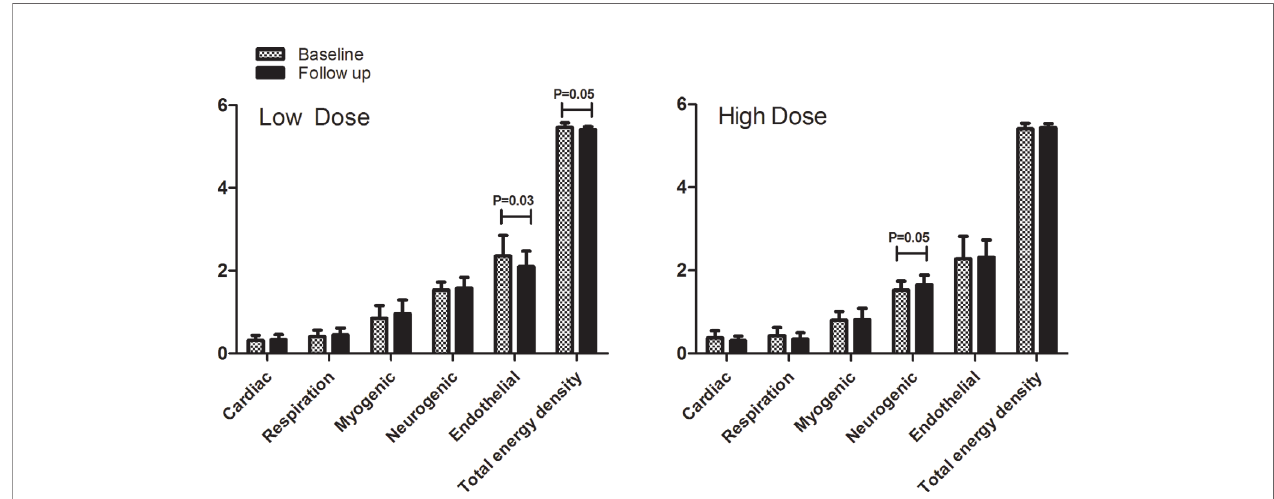
FIGURE 2 | The contribution of different frequency intervals to microvascular vasomotion (expressed in energy density) by laser Doppler of skin blood fl ow in both treatment groups before and after 24 weeks. The frequency intervals are: 0.4 – 1.6 Hz = cardiac function, 0.15 – 0.4 Hz = respiratory function, 0.06 – 0.15 Hz = myogenic response of the vascular smooth muscle cells, 0.02 – 0.06 Hz = neurogenic activity, 0.01 – 0.02 Hz = endothelial